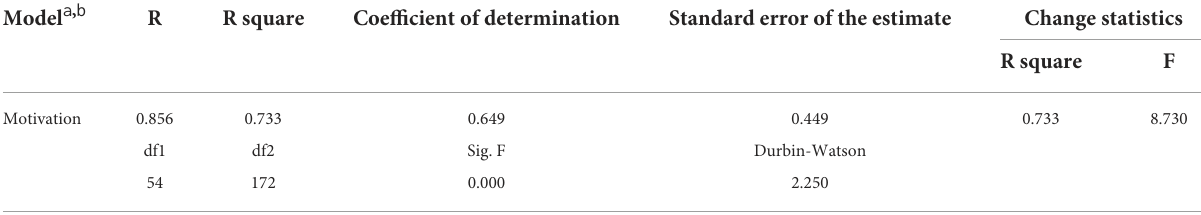
TABLE 2 Summary of the linear regression model on motivation. Model a ,